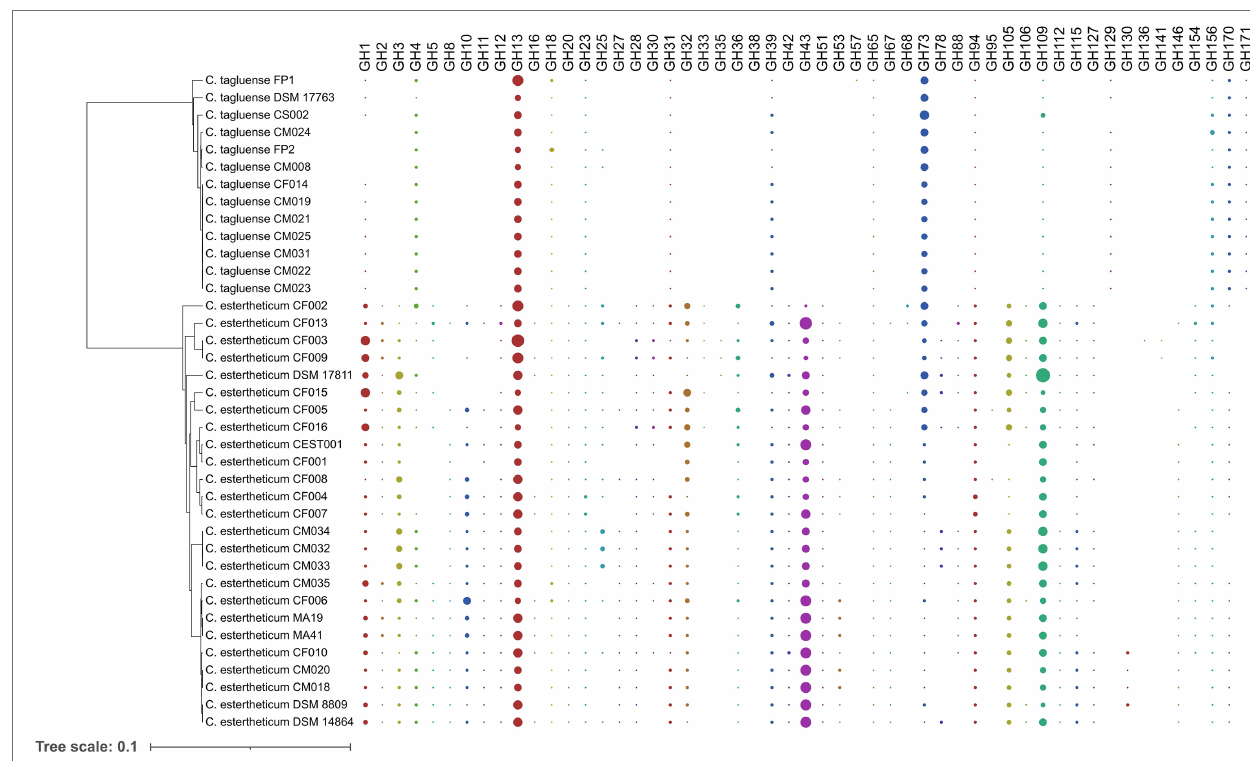
FIGURE 5 | Distribution of glycoside hydrolases in C. estertheticum and C. tagluense . The size of each circle corresponds with the frequency of the gene. A blank shows the gene is absent. The phylogeny is based on the rpoB